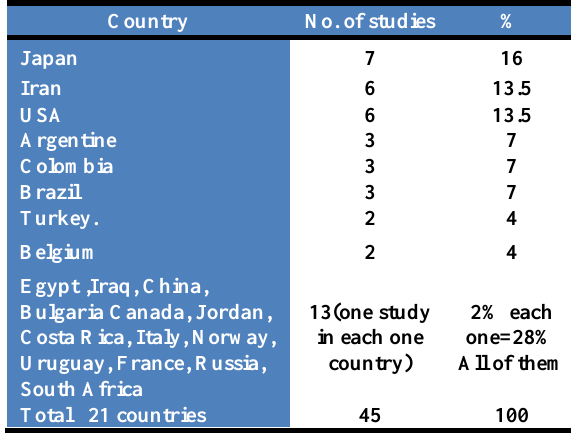
Table, 2: the studies of countries output